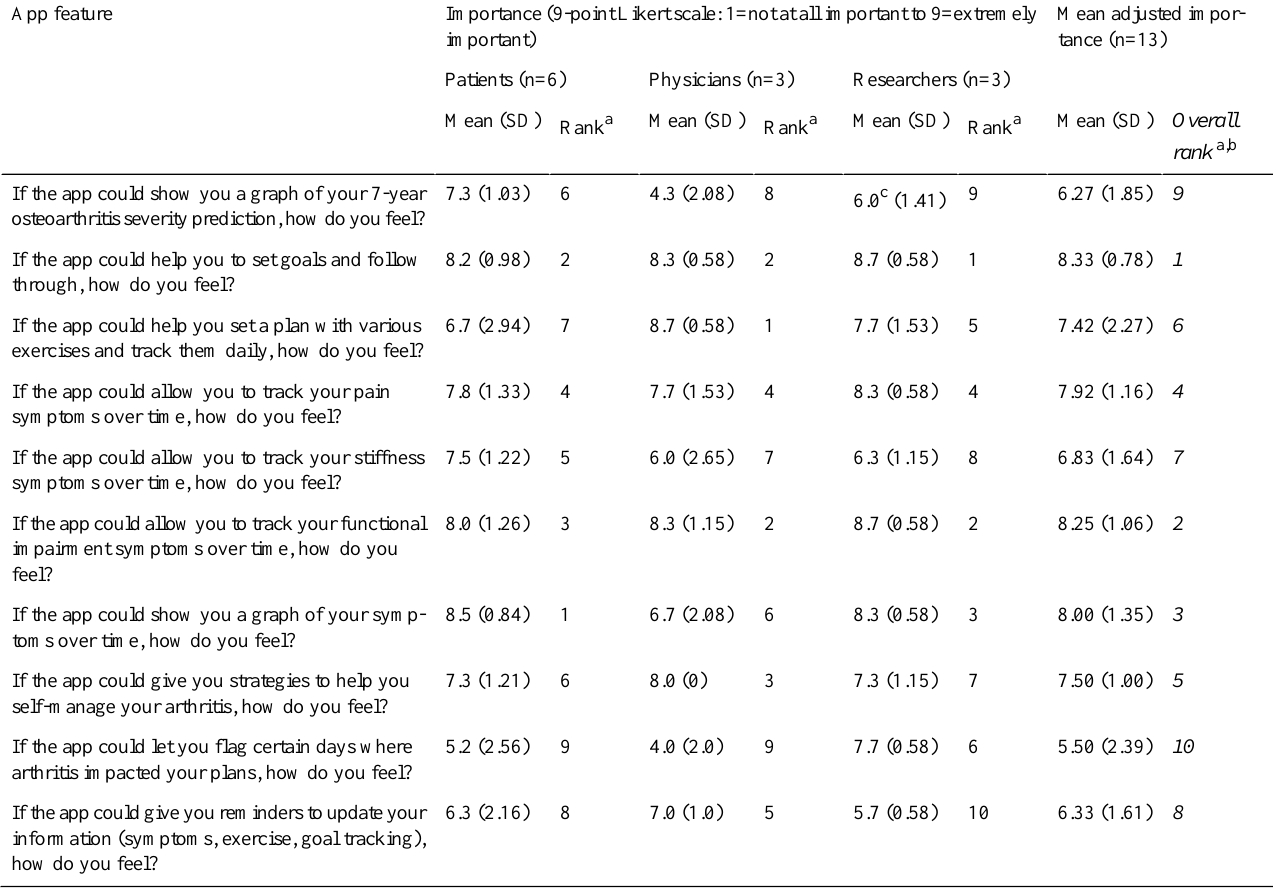
Table 3. Presession Kano survey: importance by participant group (n=13).